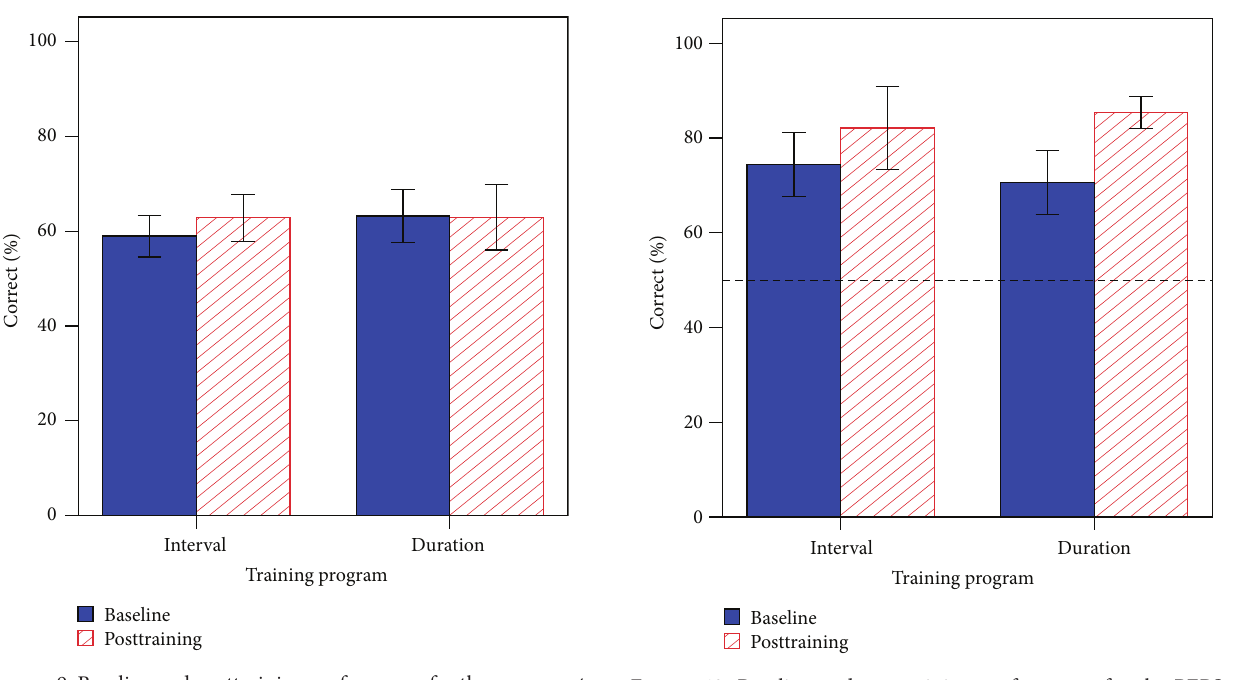
Figure 10: Baseline and posttraining performance for the PEPS- C (turn-end reception task). The dashed line indicates the chance score. Error bars indicate 1 standard